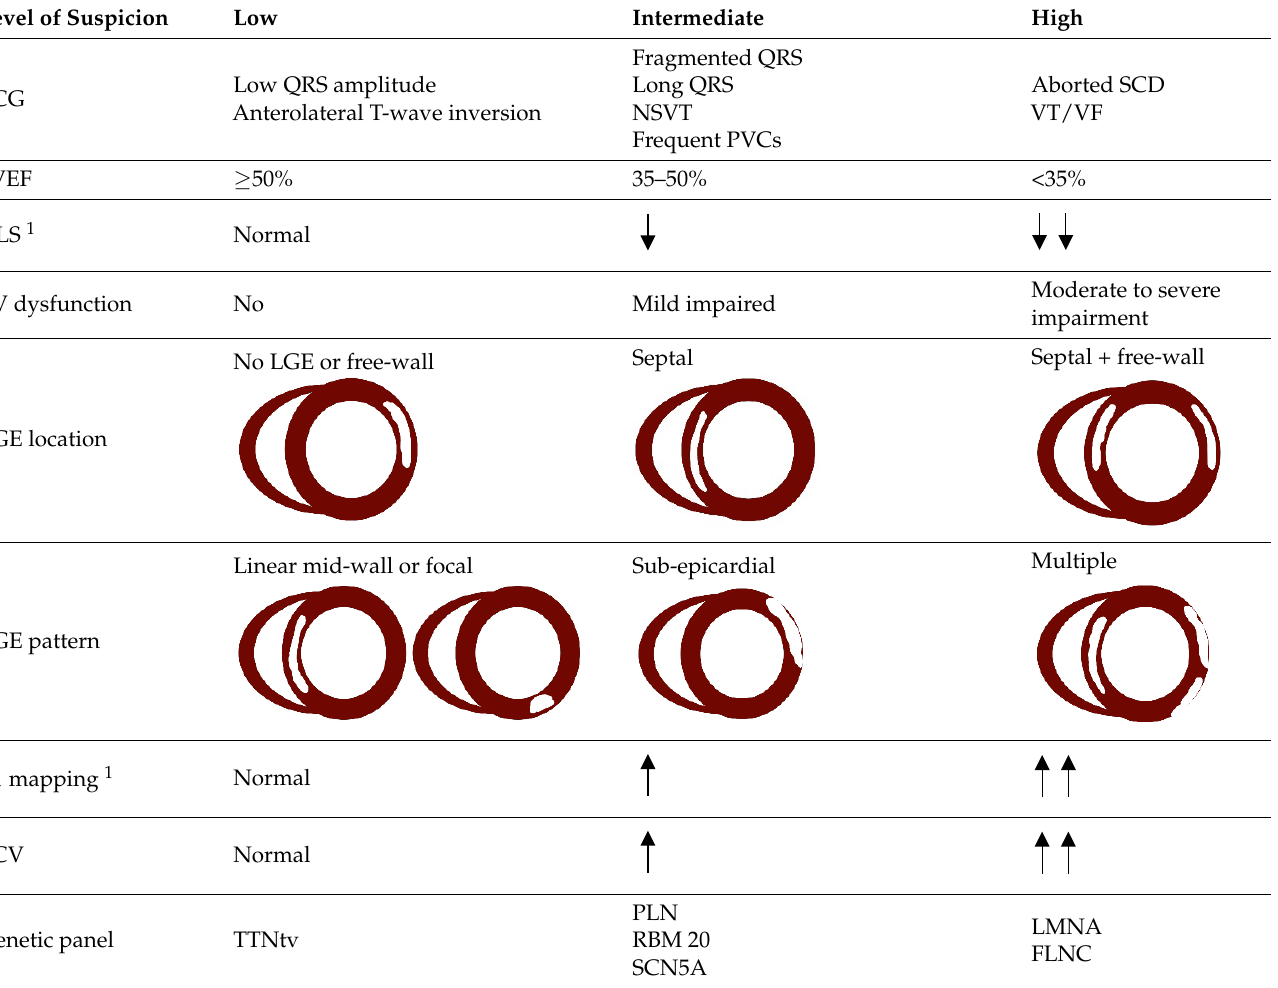
Table 2. Multiparametric approach to arrhythmic risk stratification in dilated-cardiomyopathy patients.